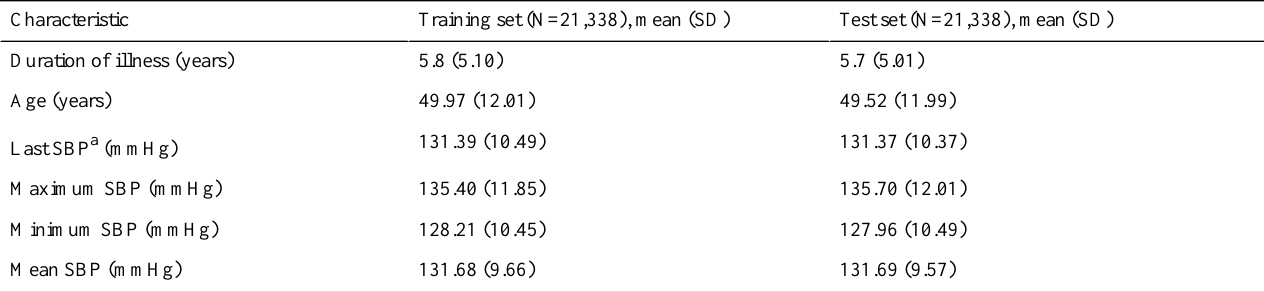
Table 2. Basic characteristics of subjects for the two